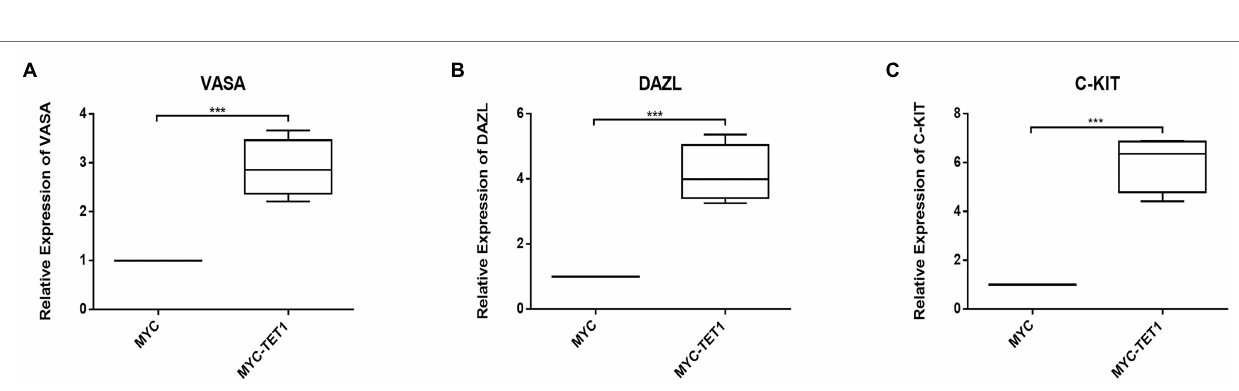
FIGURE 2 | Relative expression of specific genes in spermatogonial cells. (A) The mRNA expression of PCNA in spermatogonial cells was detected by QRT-PCR. (B) The mRNA expression of Cylin A in spermatogonial cells was detected by QRT-PCR. (C) The mRNA expression of Cylin E in spermatogonial cells was detected by QRT-PCR. (D) The expression of PCNA in TET1 overexpressed cells was detected by Western Blot. (E) Quantification of PCNA protein levels in TET1 overexpressed cells. p < .0001(****), p < .001(***), p < .01(**), p < .05(*).